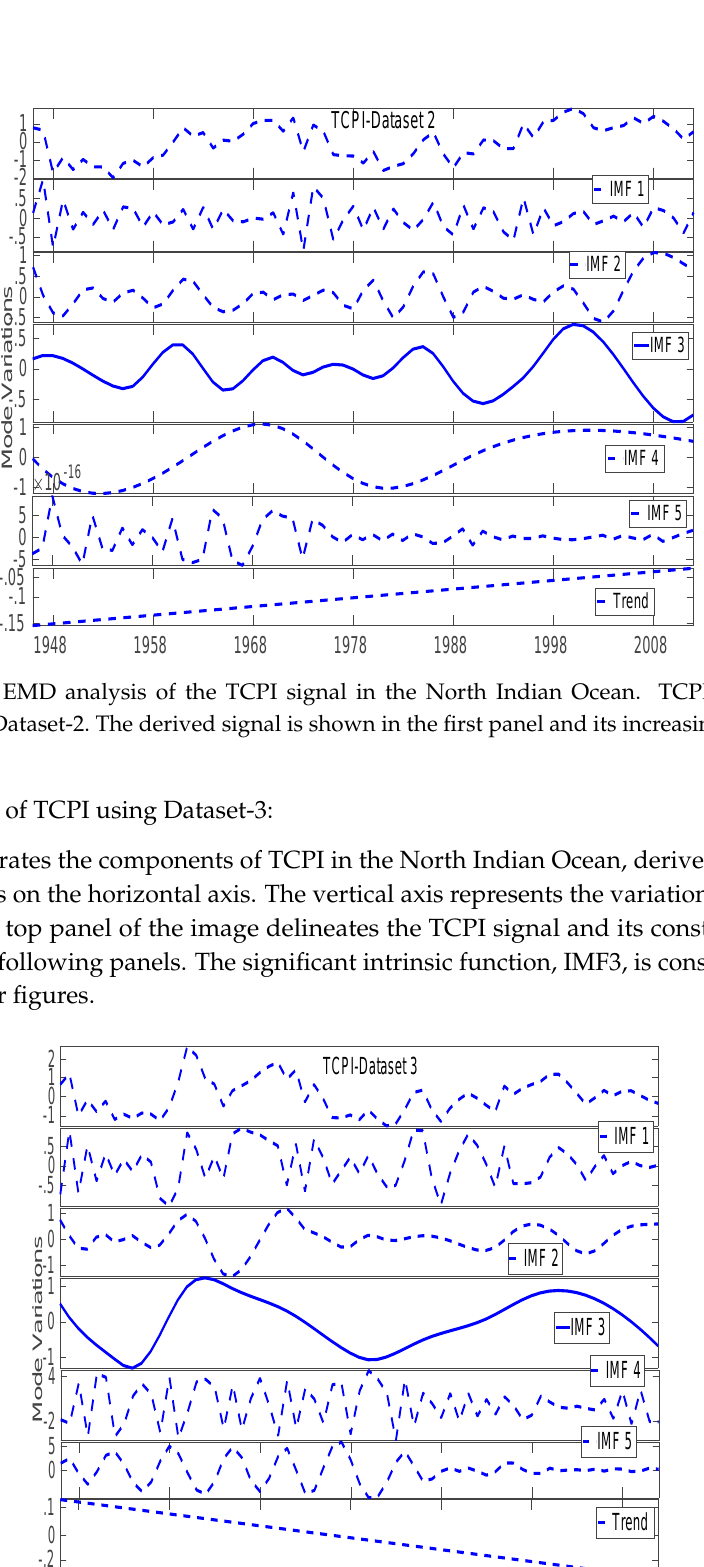
Figure 2. EMD analysis of the TCPI signal in the North Indian Ocean. TCPI derived using Dataset-1. The signal is shown in the first panel. The following panels illustrate its intrinsic modes. The trend of the signal shows a rise from 1958 onwards (Panel-7).